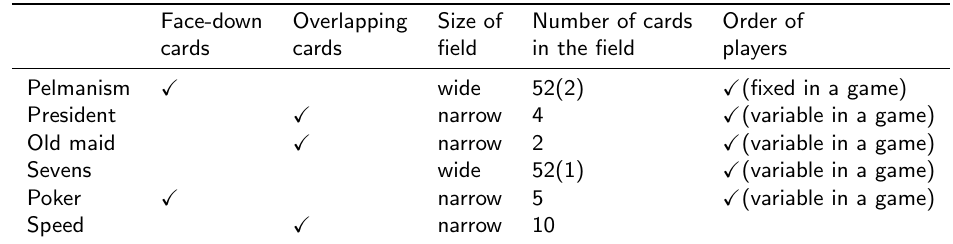
Table 2. Status of the field in card games